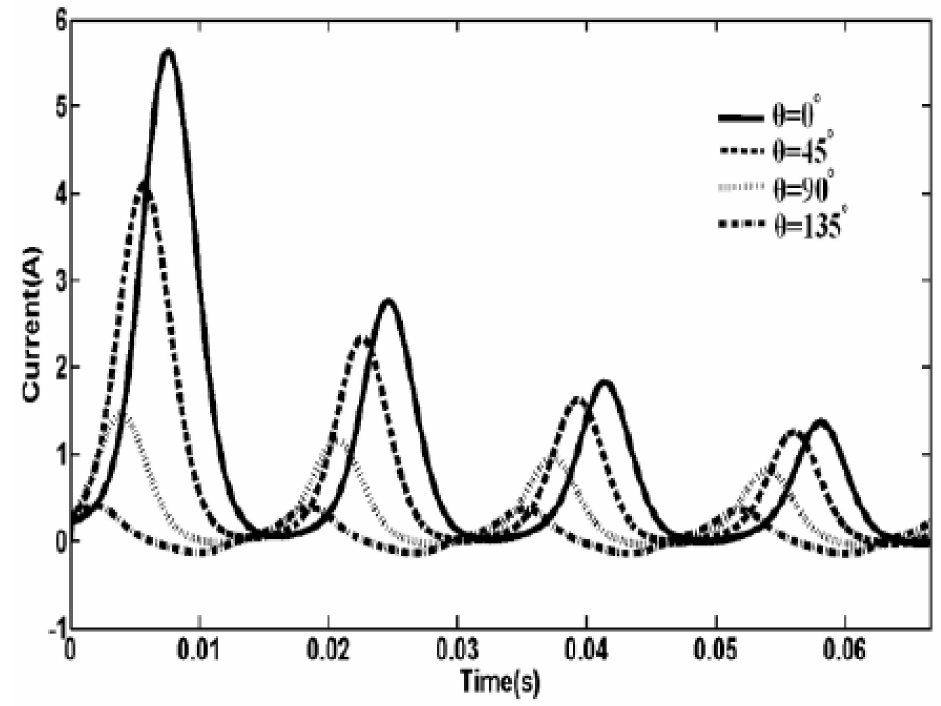
Figure 7. Variation in switching angle effects on inrush current amplitude.